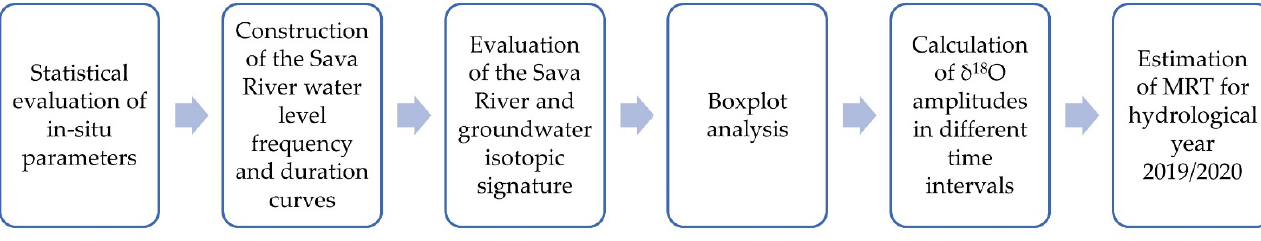
Figure 2. Analyses Figure 2. Analyses flowchart.